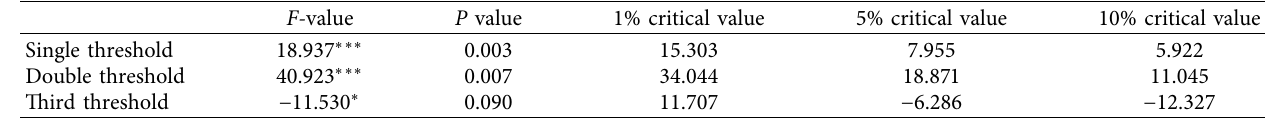
Table 7: Threshold effect